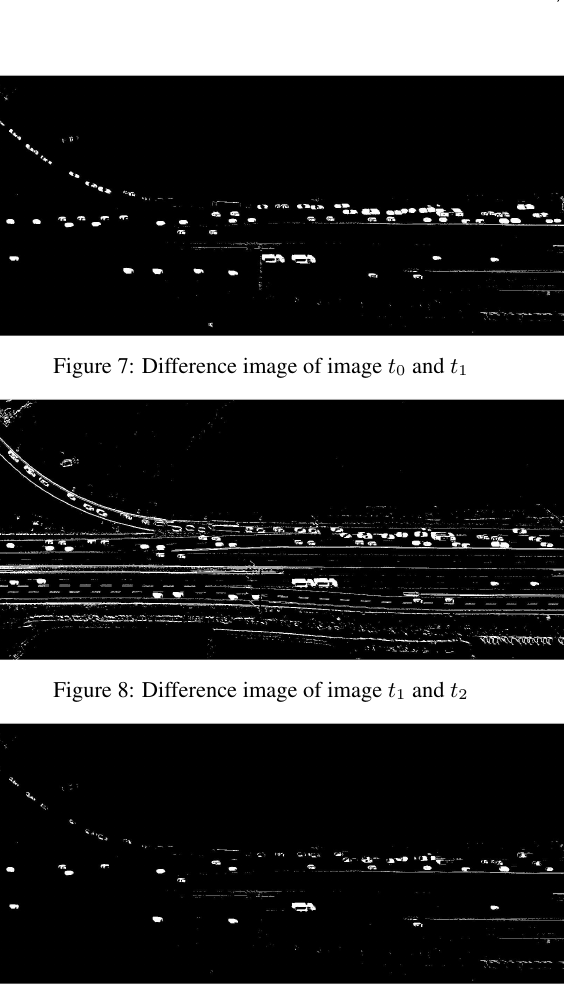
Figure 9: Boolean AND of the two difference images (Fig.7, Fig.8)